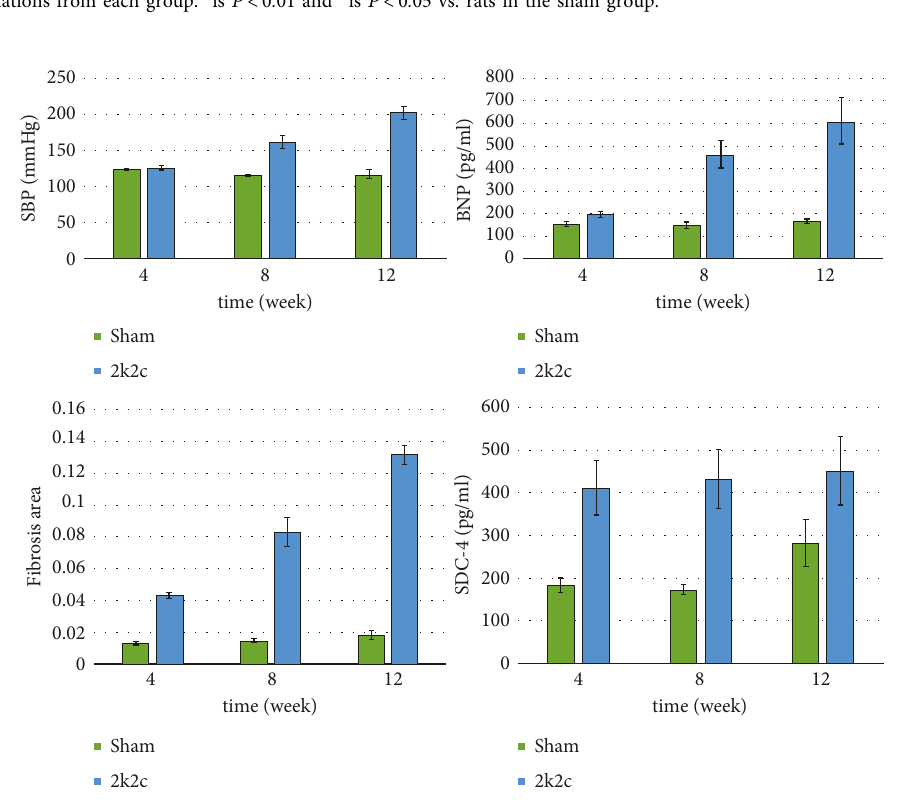
Figure 1: The change of Tei, BNP, SDC-4, and fibrosis area. Tei, the average of Teisep and Teilat; BNP, the level of B-type natriuretic peptide; SDC-4, the level of syndecan-4; and fibrosis area, the expression of fibrosis. Data are presented as the mean ± standard deviations from each group. ∗ is P < 0 .